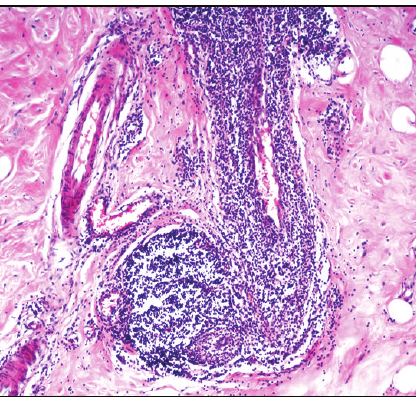
Figure 5: Microscopic images showing dense perivascular infiltrate with lymphoid follicle formation (H/E ×